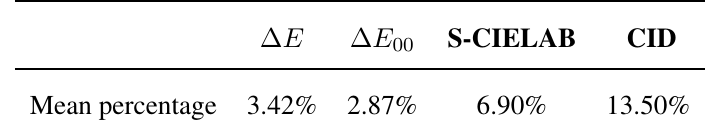
Table 8. Percentage improvement in error-metric for spherical sampling when compared to